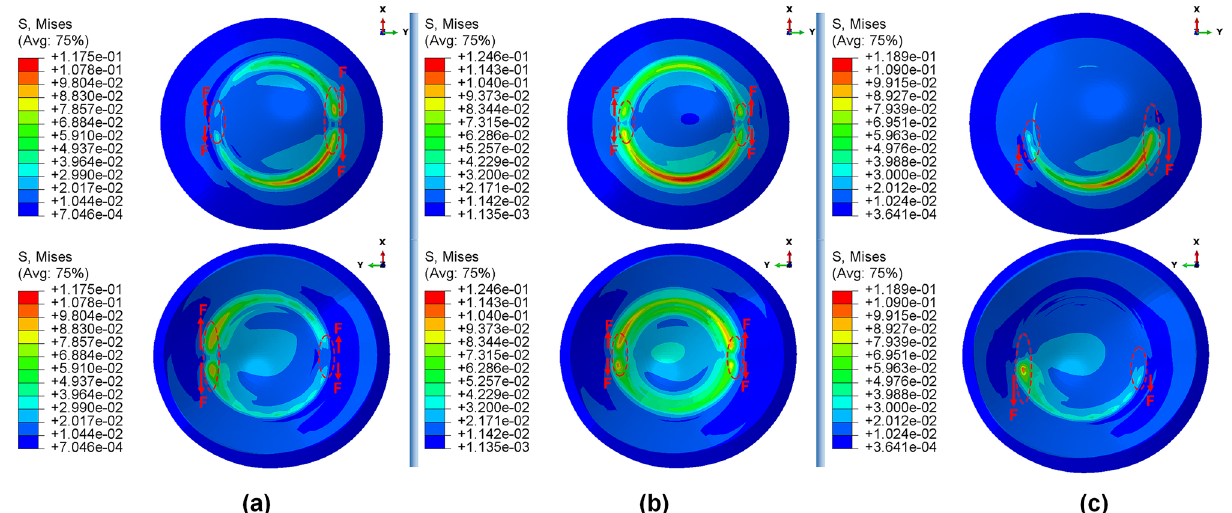
Figure 5. Comparison of the Von Mises stress distribution (MPa) and the contour of locally induced stresses at the ICRS endpoints for three different types of ICRS, including: ( a ) Kera160-two prog segments; ( b ) Kera160- two segments; ( c ) Kera160-one prog